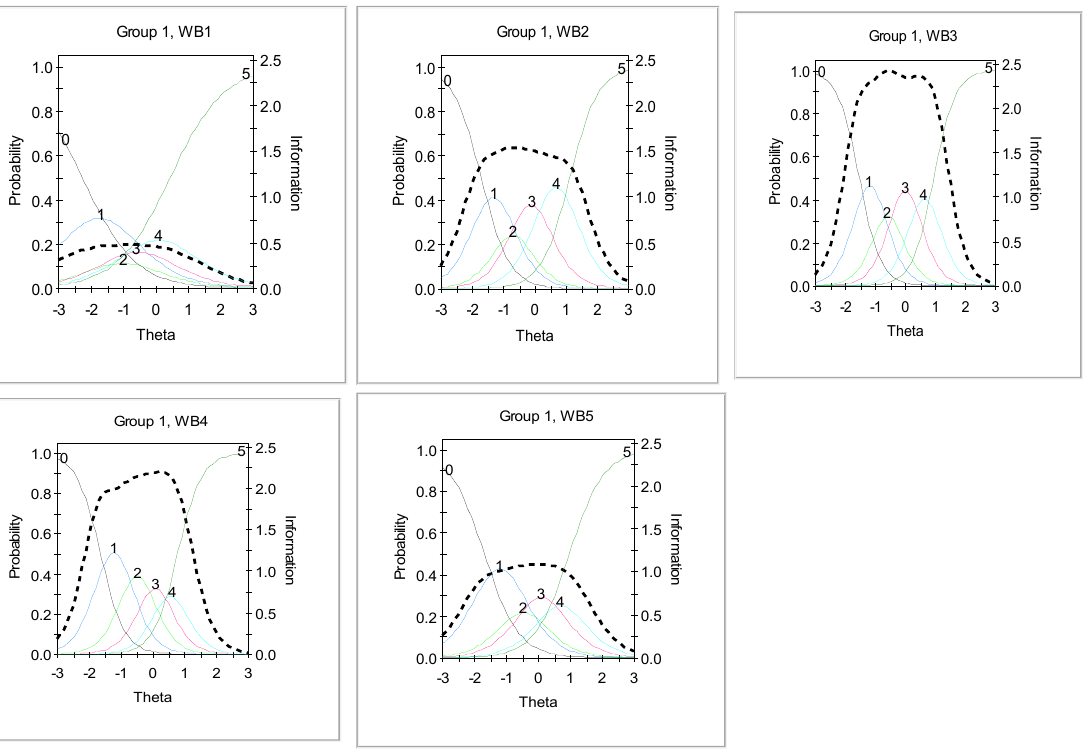
Figure 1. Trace lines and information function curves for WB1, WB2, WB3, WB4, and WB5.